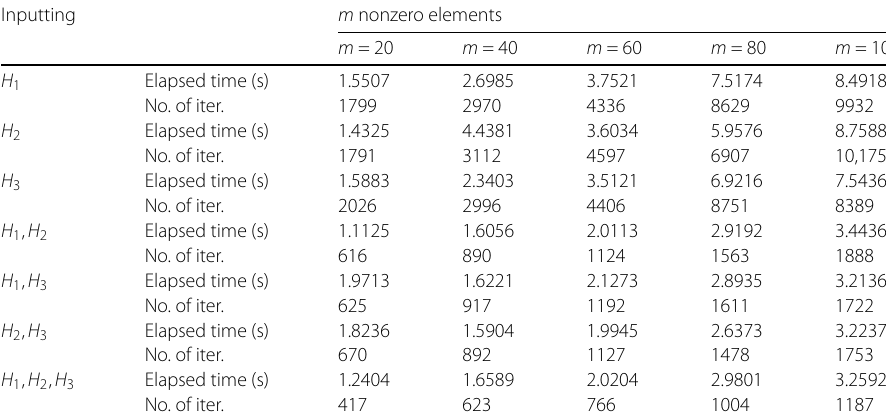
Table 8 Numerical results of PITTA